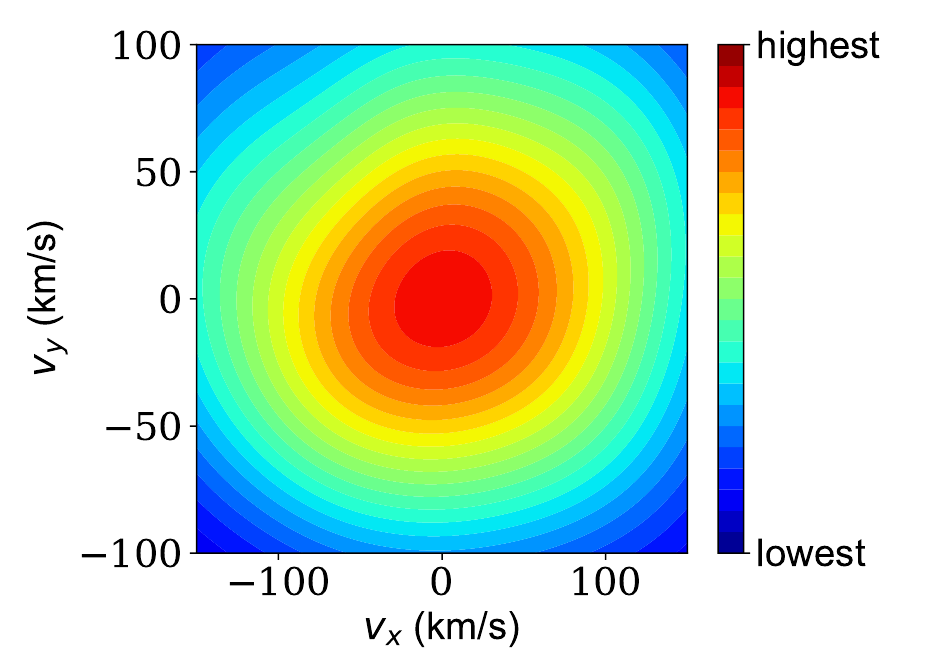
Figure A3. The probability distribution of stars’ velocities at the center, x = y = 0 in the co-moving coordinate system, of the Fornax dSph estimated using the kernel density estimator as described in Section 4. The distribution is close to the Maxwell–Boltzmann distribution function although a slight deviation can be seen. The deviations are slightly different at other ( x , y ) positions leading to the mass density fluctuations of Figure